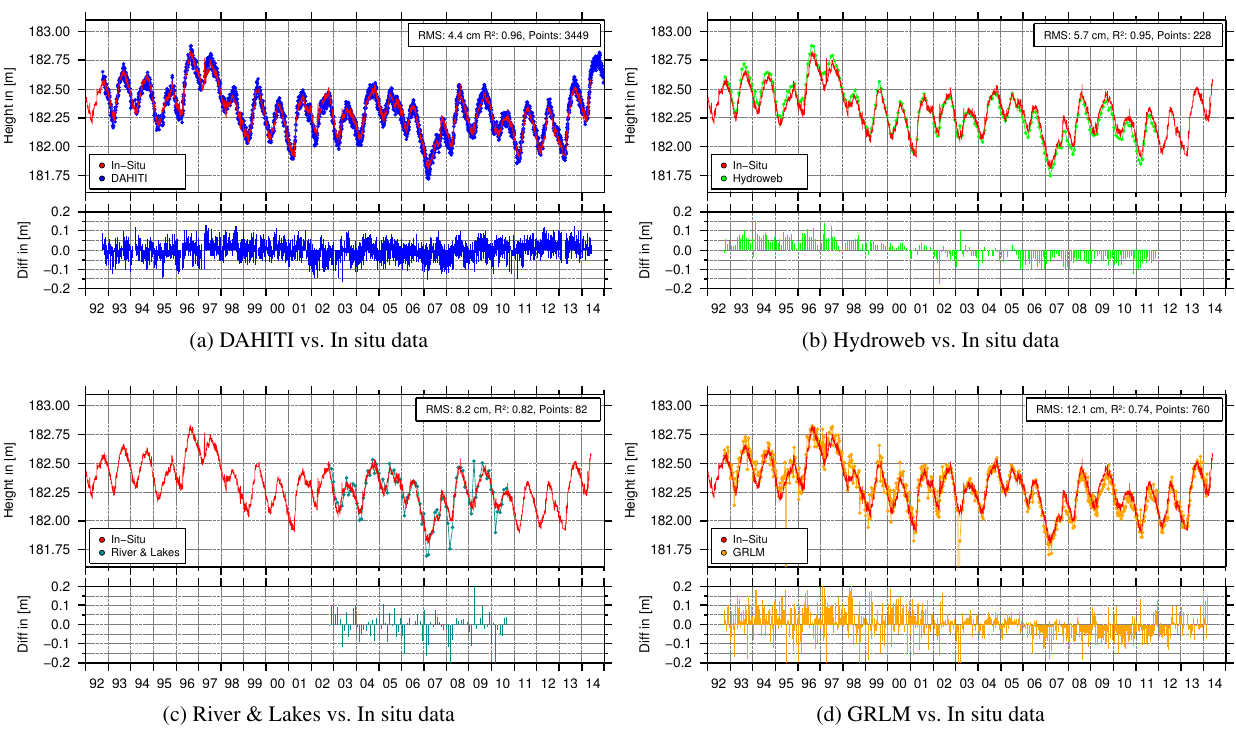
Figure 6. Water level time series of Lake Superior from DAHITI (1992–2014), Hydroweb (1992–2011), River & Lake (2002–2010) and GRLM (1992–2014) compared with in situ data (Ontonagon, 1992–2014) and shifted to the water level height of the in situ data. Additionally, differences between heights from altimetry and in situ data are plotted for periods in which both data sets are available.